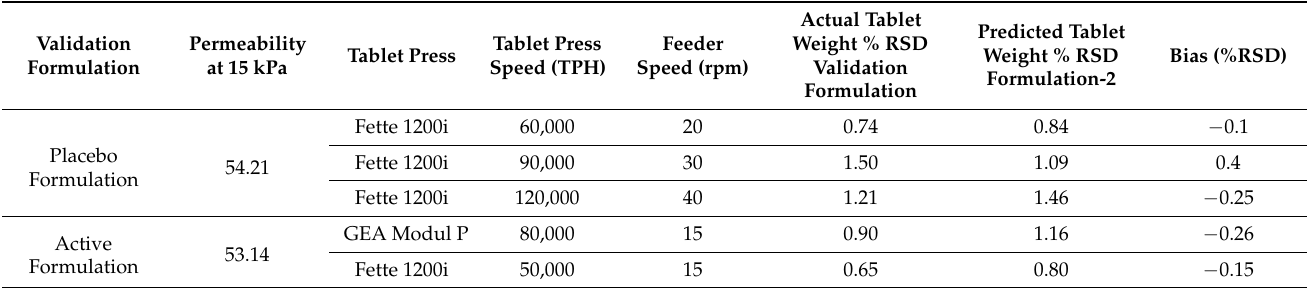
Table 5. Permeability values for validation formulations, validation process settings, process model, actual tablet weight variability (%RSD) for validation formulations and predicted tablet weight variability (%RSD) values calculated by the process model, benchmarking validation formulations to formulation-2 (fair flow).